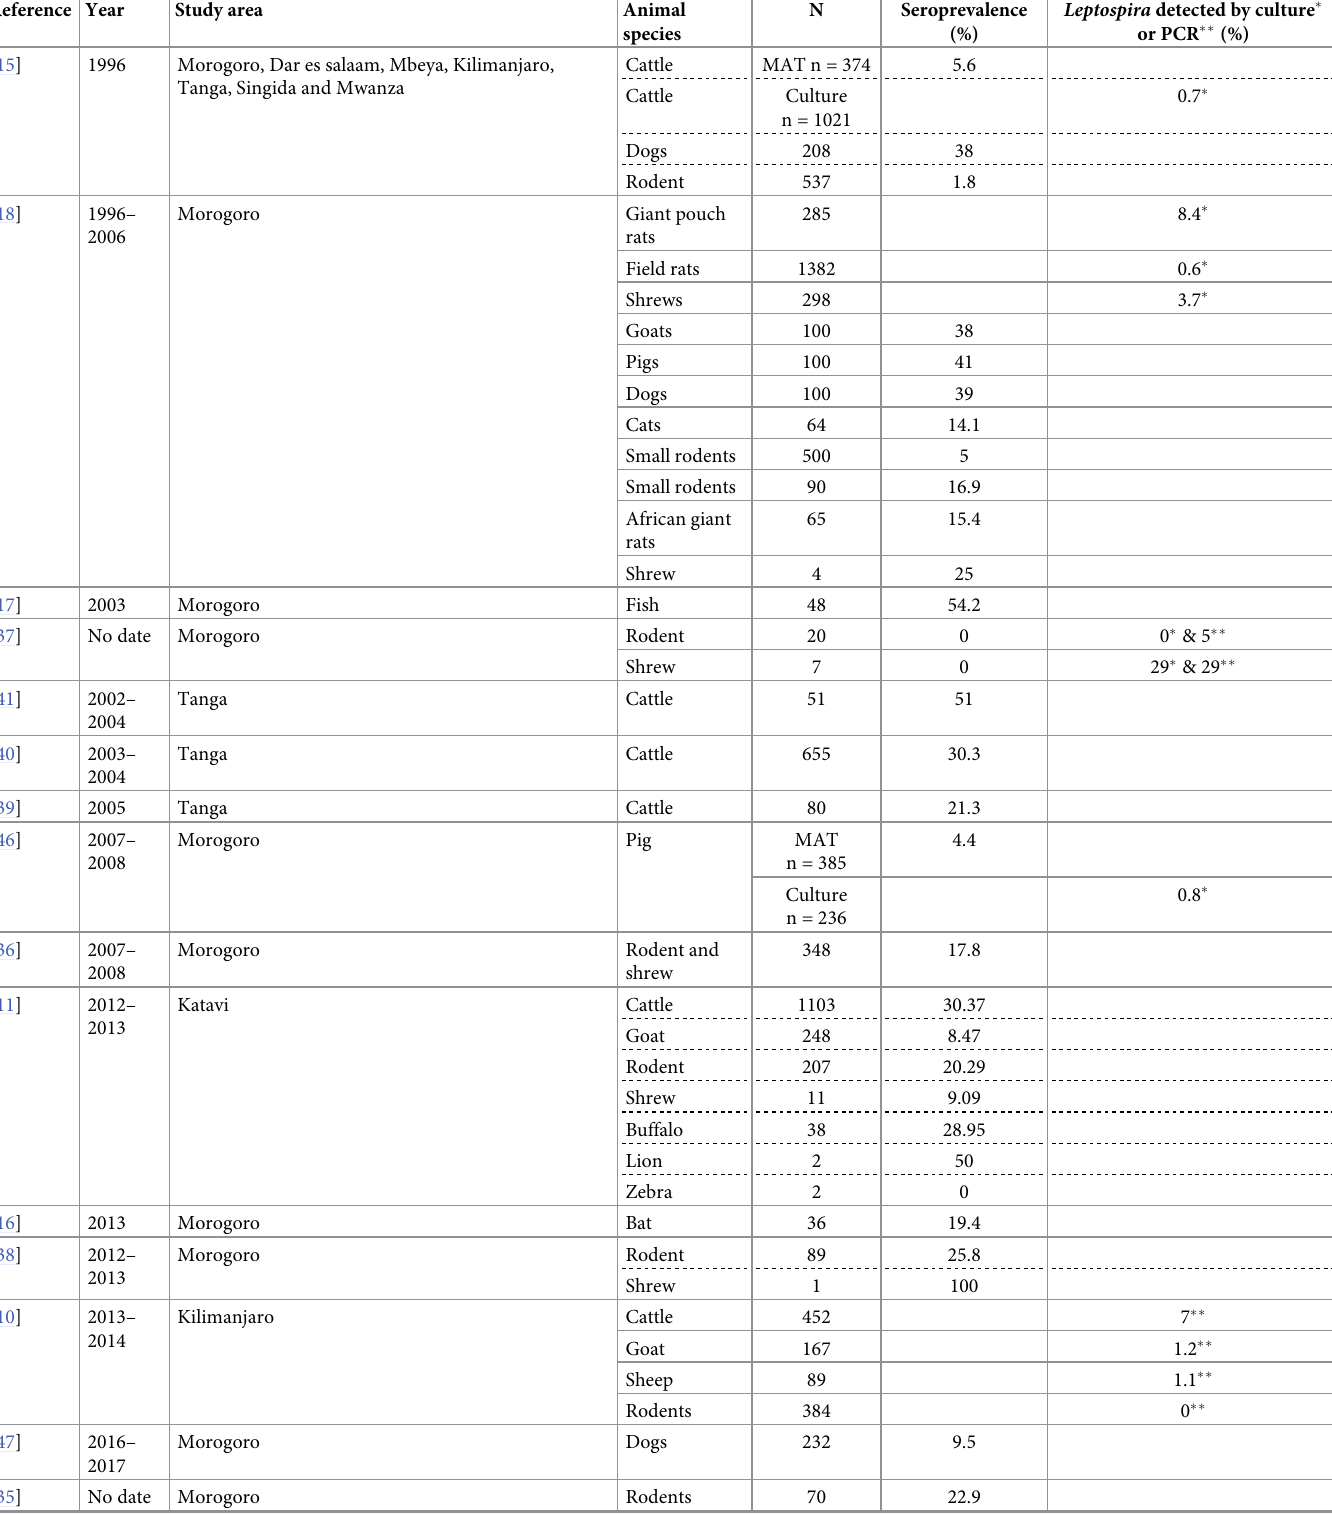
Table 3. Summary of studies reporting animals with leptospirosis in Tanzania